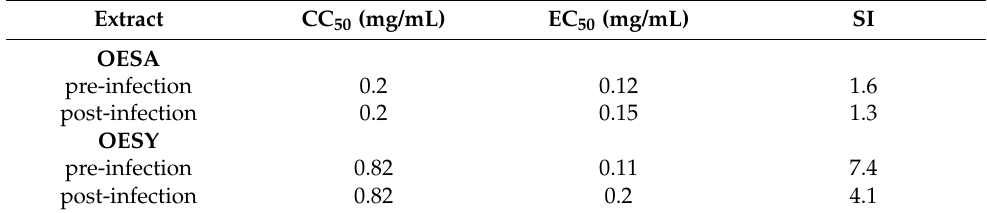
Table 4. Selectivity index (SI), cytotoxicity (CC 50 ), and antiviral activity (EC 50 ) of OESA and OESY leaf